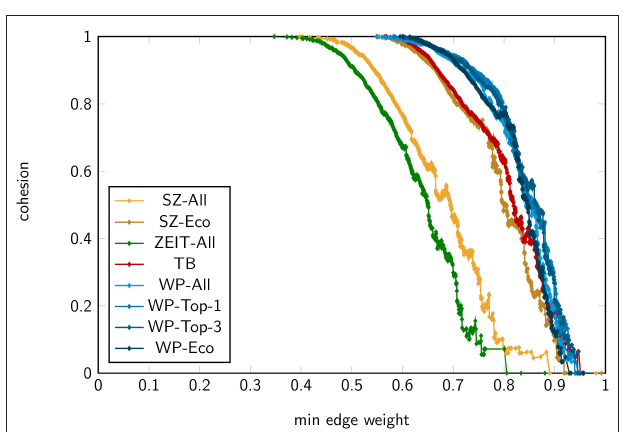
FIGURE 9 | Network clustering per α -cut ( α = minimal allowable edge weight) of word embedding networks of threshold concepts (TCNs) based on the skip-gram